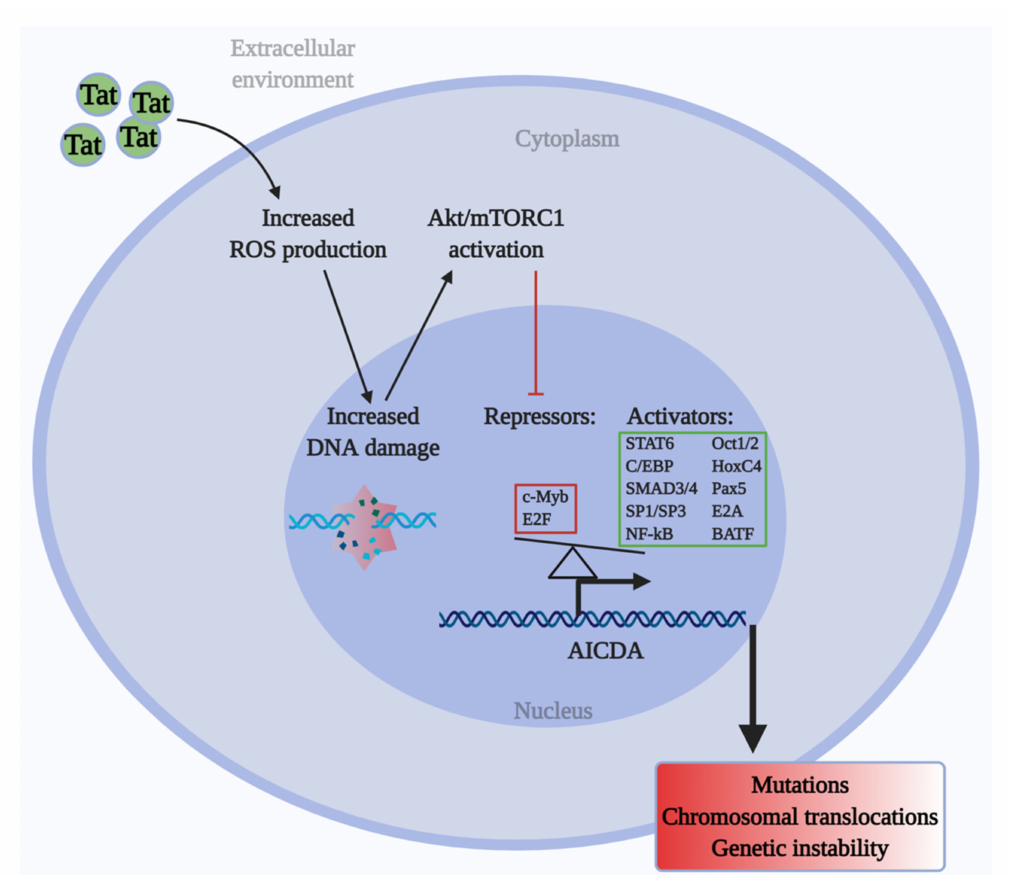
Figure 5. Oncogenic effects of HIV-Tat in B cells. Tat increases the ROS production [15], leading to the induction of DNA damage and activation of the Akt/mTORC1 pathway. This results in the increased expression of AICDA due to the mTORC1-dependent inhibition of its transcriptional repressors. Deregulated expression of AICDA increases the possibility of increased mutations and chromosomal translocations causing genetic instability in B cells, leading to the emergence of B-cell